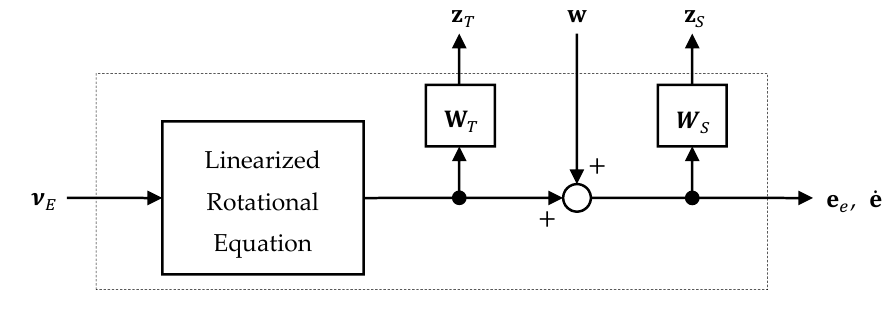
Figure 7. Generalized plant.